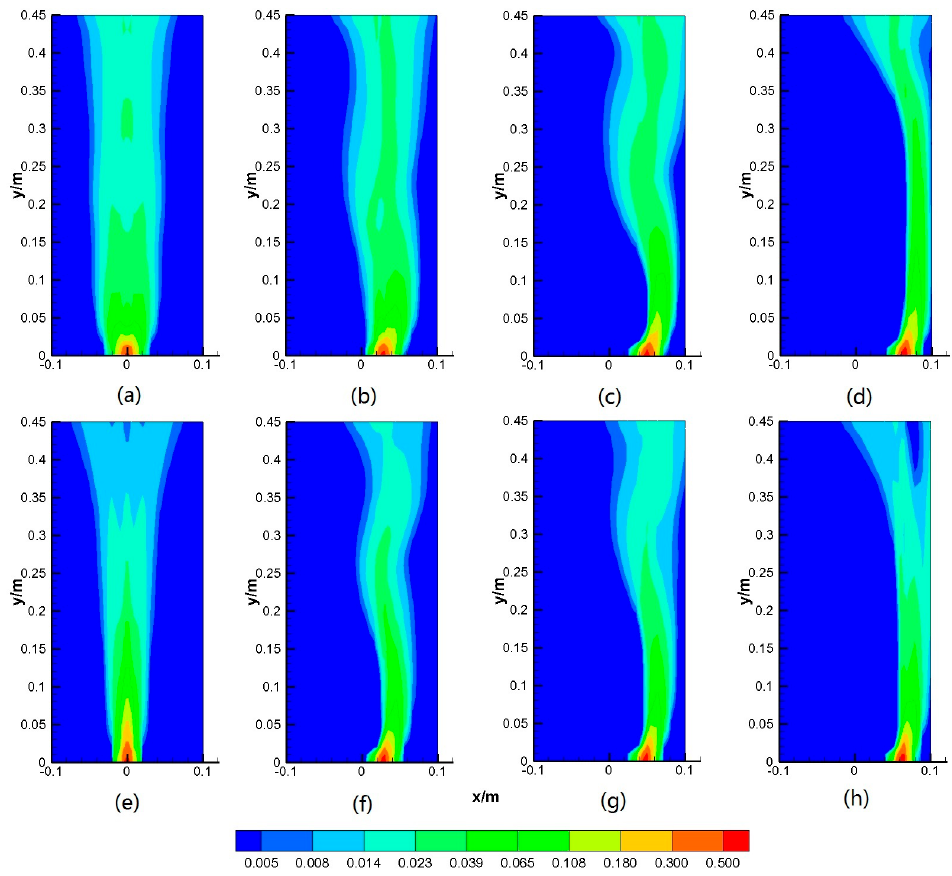
Figure 9. Gas hold-up distribution at z = 0 m in the bubble column: ( a ) case 1 (NEW-0), ( b ) case 2 (NEW-0.025), ( c ) case 3 (NEW-0.045), ( d ) case 4 (NEW-0.06), ( e ) case 5 (NON-0), ( f ) case 6 (NON-0.025), ( g ) case 7 (NON-0.045), and ( h ) case 8 (NON-0.06).